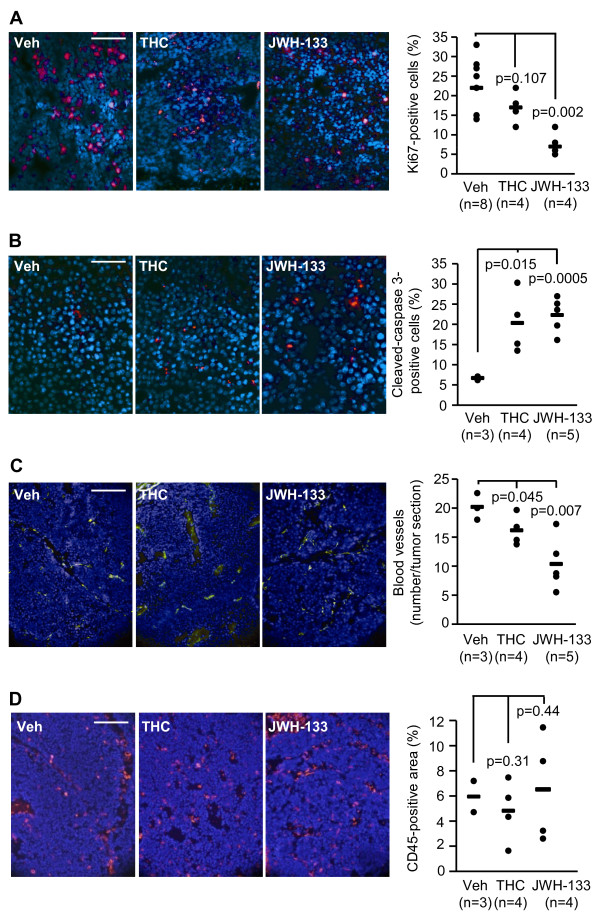
Cannabinoids inhibit cancer cell proliferation, induce cancer cell apoptosis, and impair tumor angiogenesis in vivo. (A) Ki67-positive cells (red), (B) active caspase-3-positive cells (red), (C) CD31-positive cells (green) and (D) CD45-positive area in the tumors. Scale bars: A, 60 μm; B, 40 μm; C and D, 100 μm. Cell nuclei are in blue. Quantifications of Ki67-positive cells (A), active caspase-3-positive cells (B), the number of blood vessels (C) and CD45-positive area (D) in the tumors are shown in the corresponding graphs.